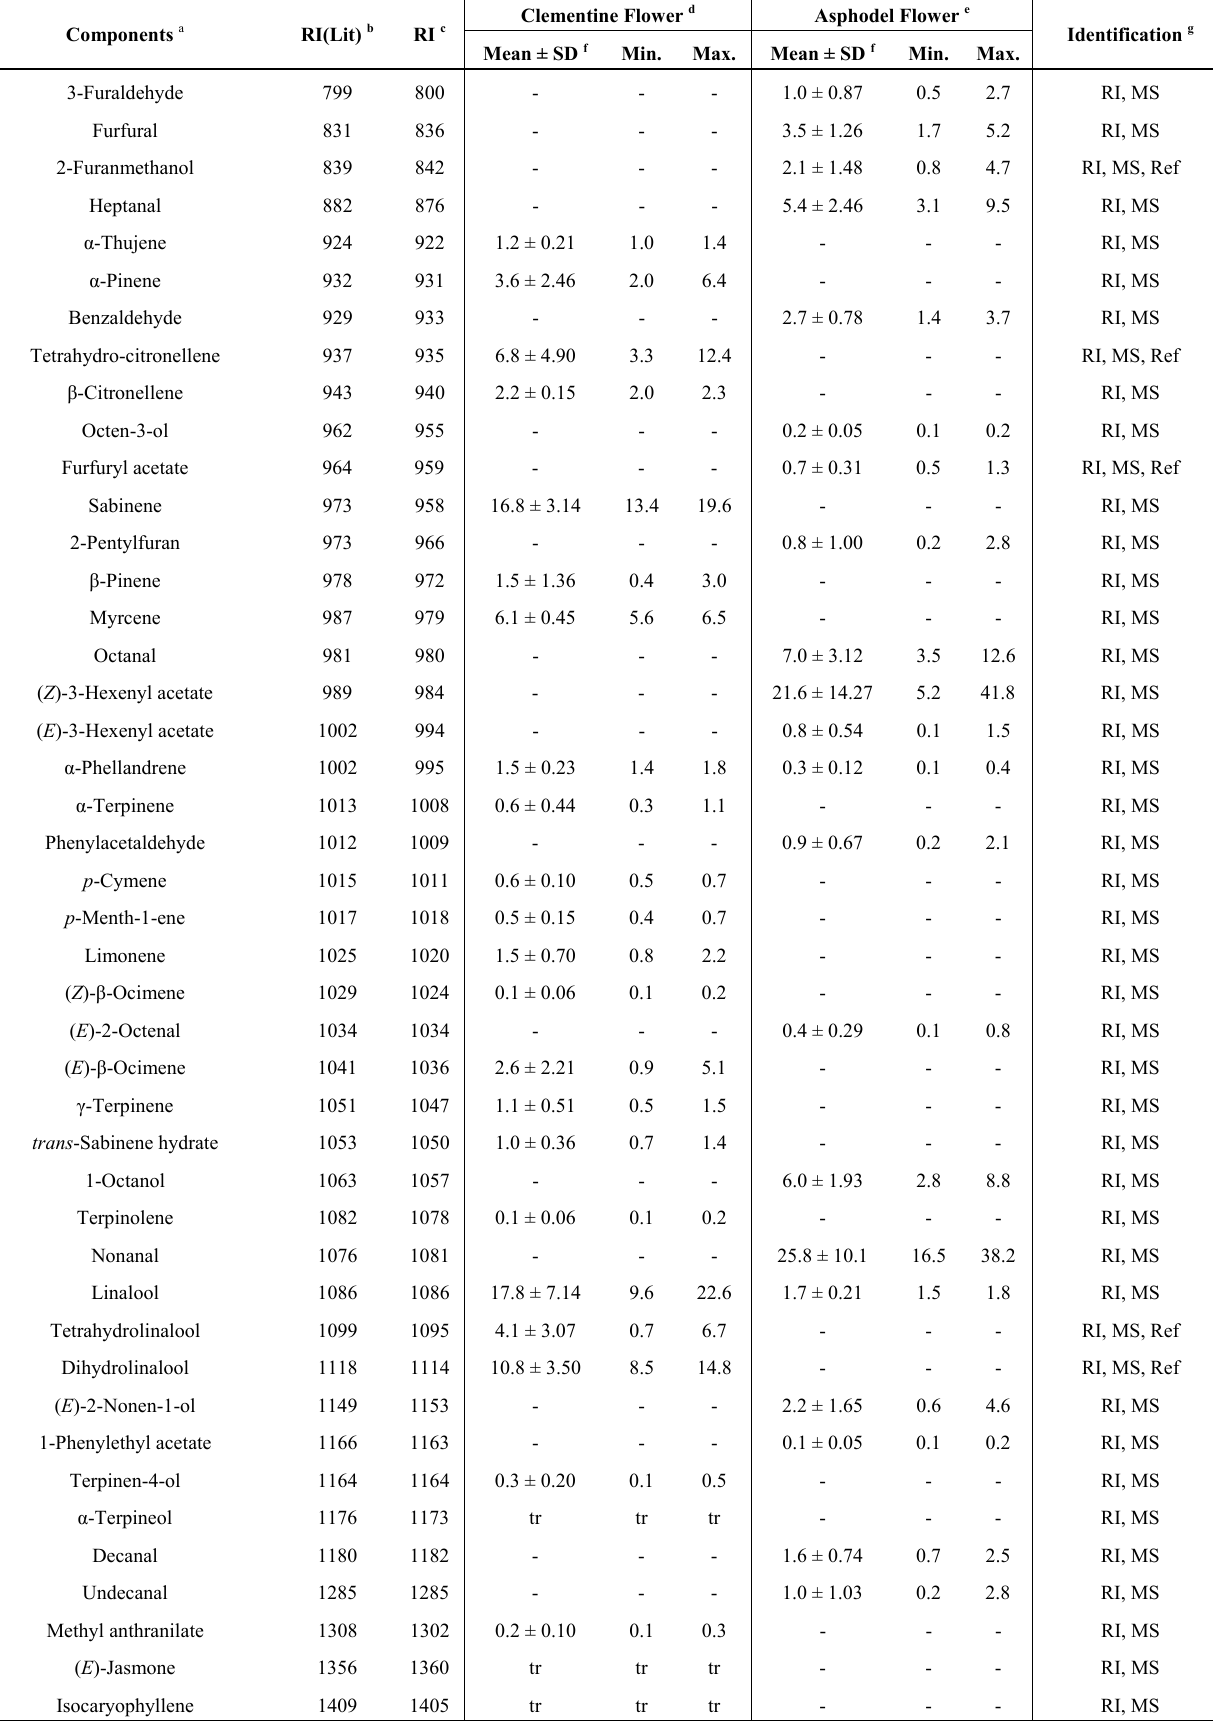
Table 4. Chemical composition of volatile fraction of clementine and asphodel flowers. Components